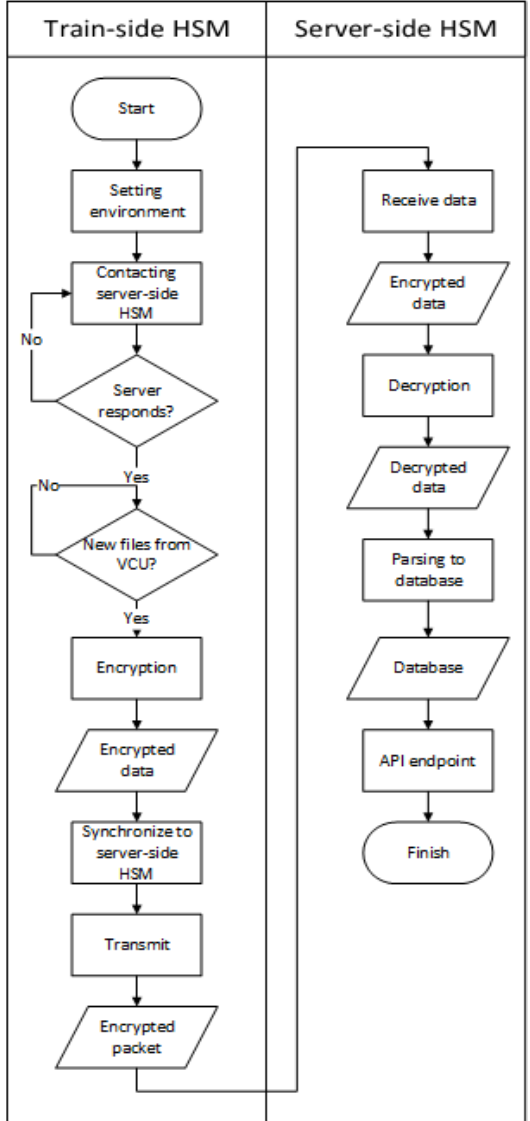
Figure 4. Securebox HSMs functional flow.